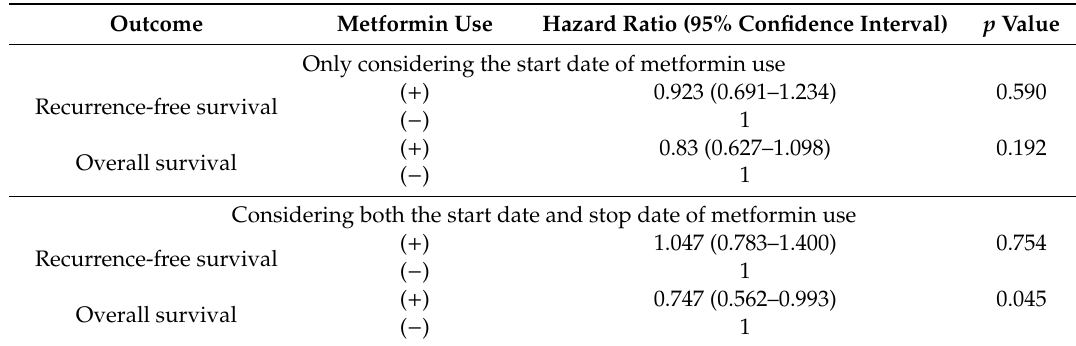
Table 3. Adjusted analysis using Cox models with time-varying